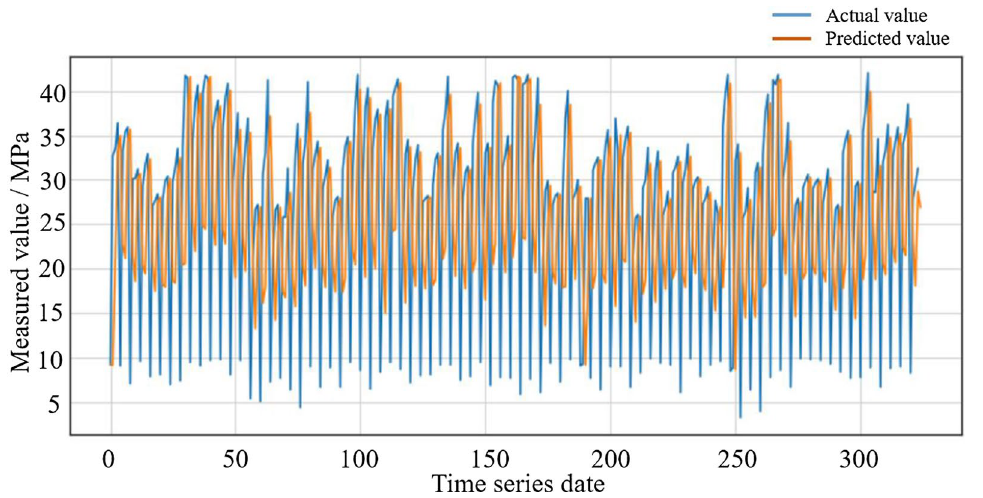
Fig. 8 Support load predictions based on the sliding window model